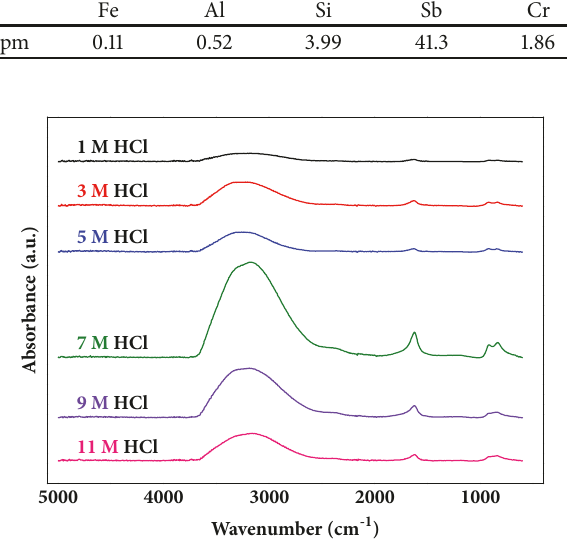
Figure 3: FT-IR analysis of various commercial titanium tetrachlo- ride samples via dilution in 7M hydrochloric